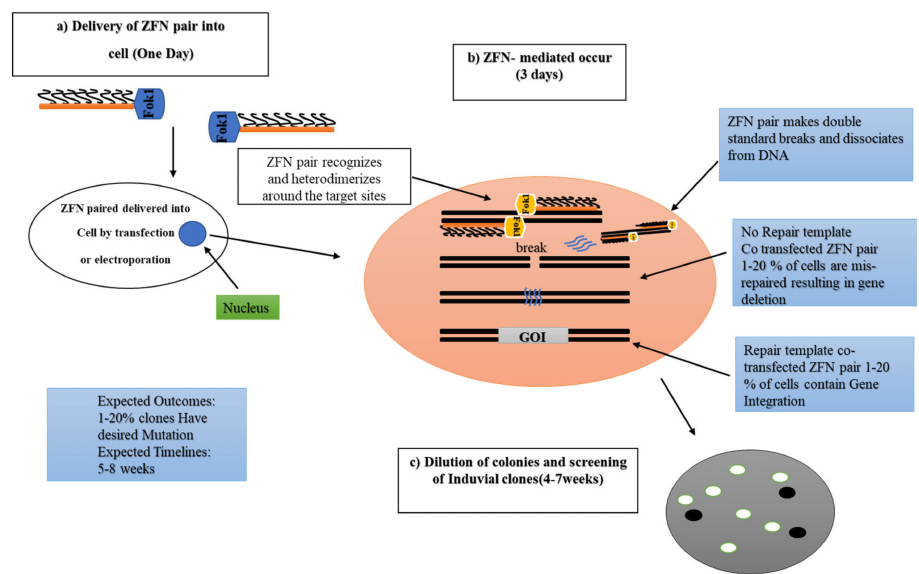
Figure 2. Processes of Zinc-finger nucleases (ZFNs). ( a ) Delivery of ZFNs into cells by transfection or electroporation. ( b ) ZFNs are fusions of the nonspecific DNA cleavage domain of the FokI restriction nuclease with zinc-finger proteins. ZFN dimers induce targeted and double-stranded breaks (DSBs) to stimulate the DNA damage response pathways. The binding specificity of the designed zinc-finger domain directs the ZFN to a particular genomic site. The boxes with blue color represent the mechanism of the ZFN genome-editing technique. ( c ) Cloning of ZFN-genome-edited cells and screening of positive clones by RT-PCR and sequencing analyses. This figure briefly modified from the source (https: // www.sigmaaldrich.com / technical-documents / articles / life-science-innovations / targeted- genome-editing.html).